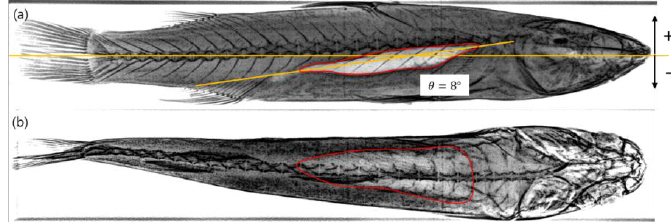
Figure 7. X-ray images of the mullet’s swim bladder; ( a ) lateral aspect, and ( b ) dorsal aspect). The red lines is the boundary of the swim bladder.